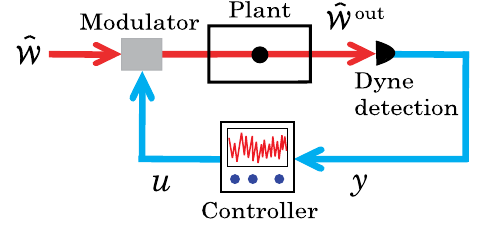
FIG. 5. General configuration of the type-1 MF